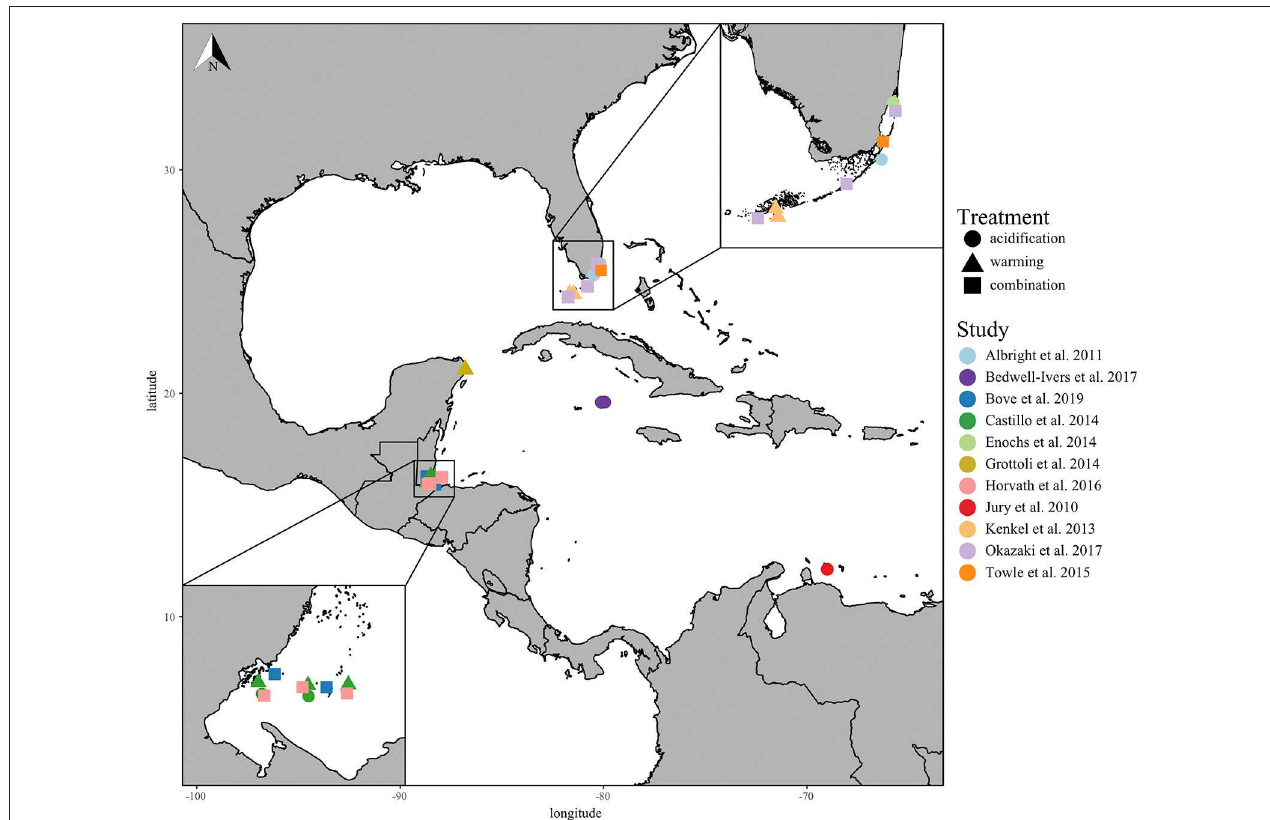
FIGURE 1 | Coral collection sites of all included studies with experimental study represented by color and treatments represented by shape: acidification only (circle), warming only (triangle), and the combination of acidification and warming (square). The lower left insert displays close-up of the Belize collection sites and the upper right insert displays the Florida Keys collection